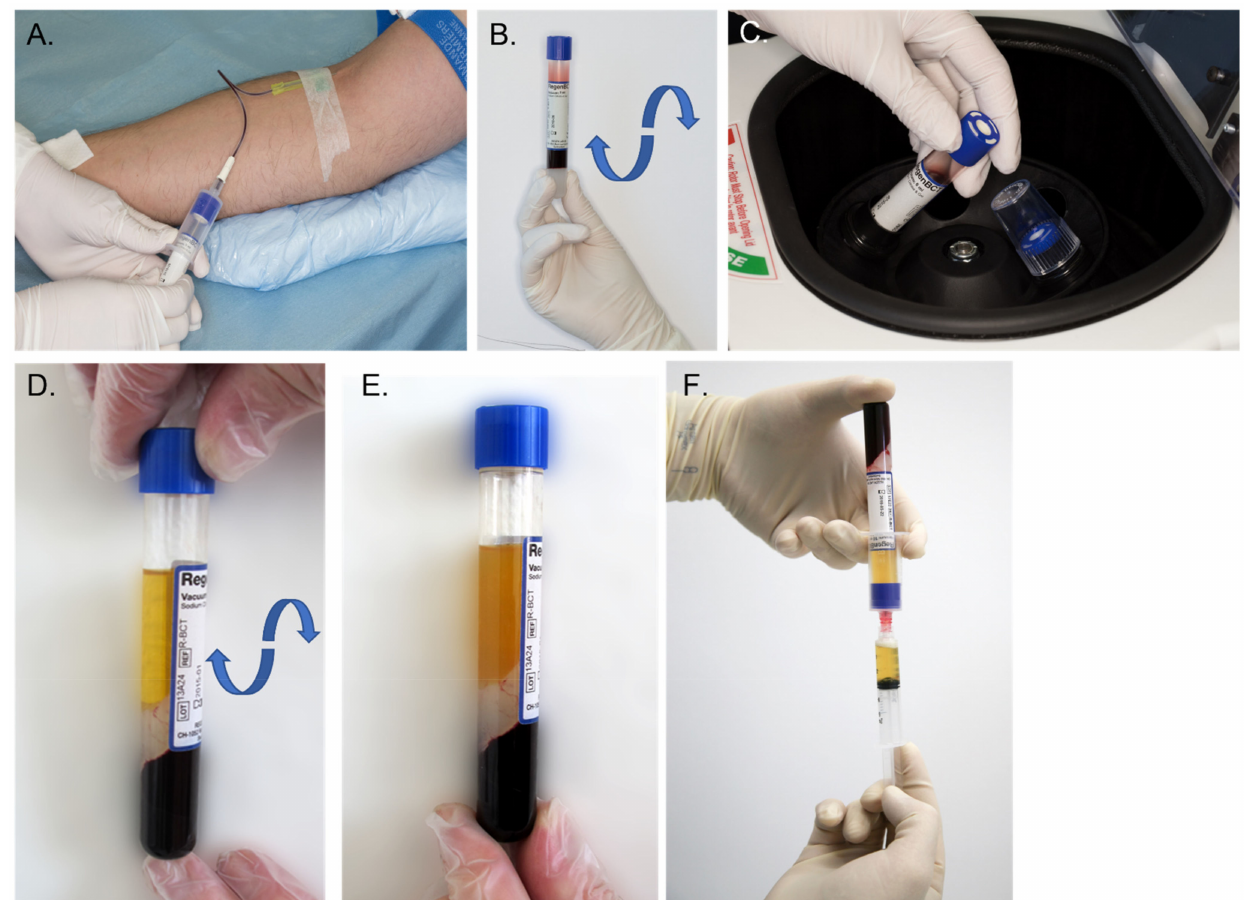
Figure 1. Process of standardized PRP production. Regen PRP tubes are designed for a use in a closed circuit to maintain the sterility of the biological samples. ( A ) The venous puncture is performed, and the desired number of Regen PRP tubes are filled with whole blood. The vacuum within the tubes enables automatic collection of the necessary volume of blood (about 10 mL). ( B ) The tubes are carefully reversed upside down three times to mix the blood with the anticoagulant. ( C ) The tube is centrifuged with a relative centrifugal force of 1500 g for 5 to 9 min. ( D ) After centrifugation, the blood is fractionated; the red and white blood cells are trapped under the gel, and platelets settle on the surface of the gel. ( E ) The tube is gently rocked to re-suspend the platelets. ( F ) The resulting PRP is collected with a syringe connected to a transfer